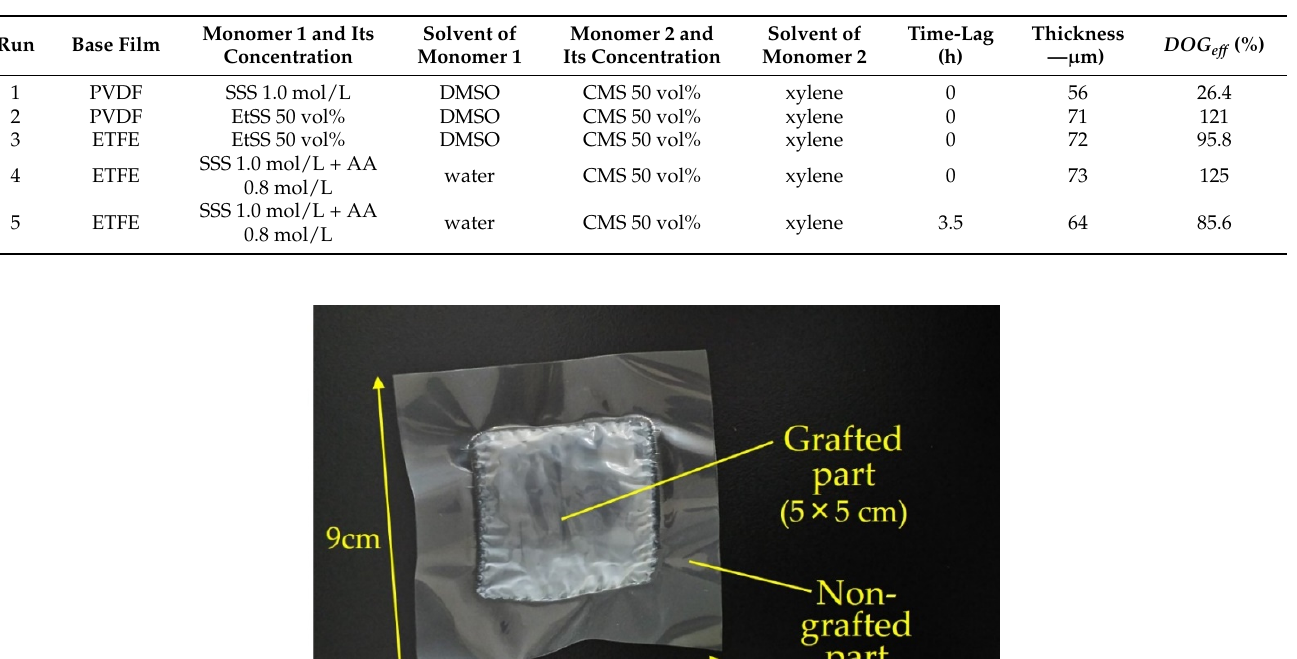
Table 4. Experimental conditions of RIAGP and obtained effective degree of grafting ( DOG eff ) .